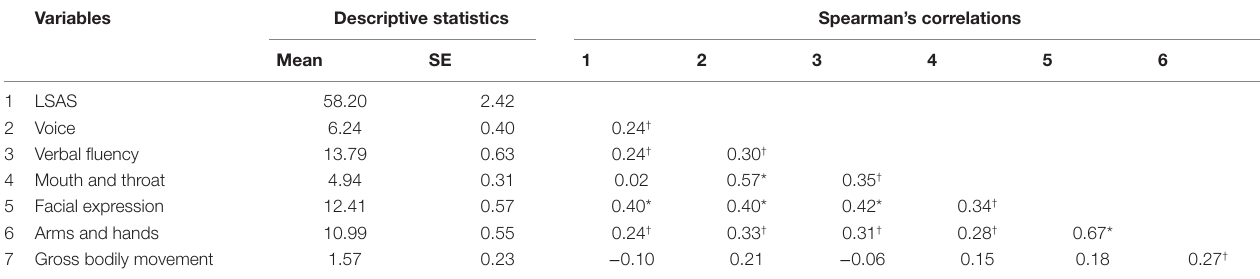
TaBle 3 | relations between social anxiety symptoms and anxiety behavior ratings based on the Behavioral assessment of speech anxiety (Basa).